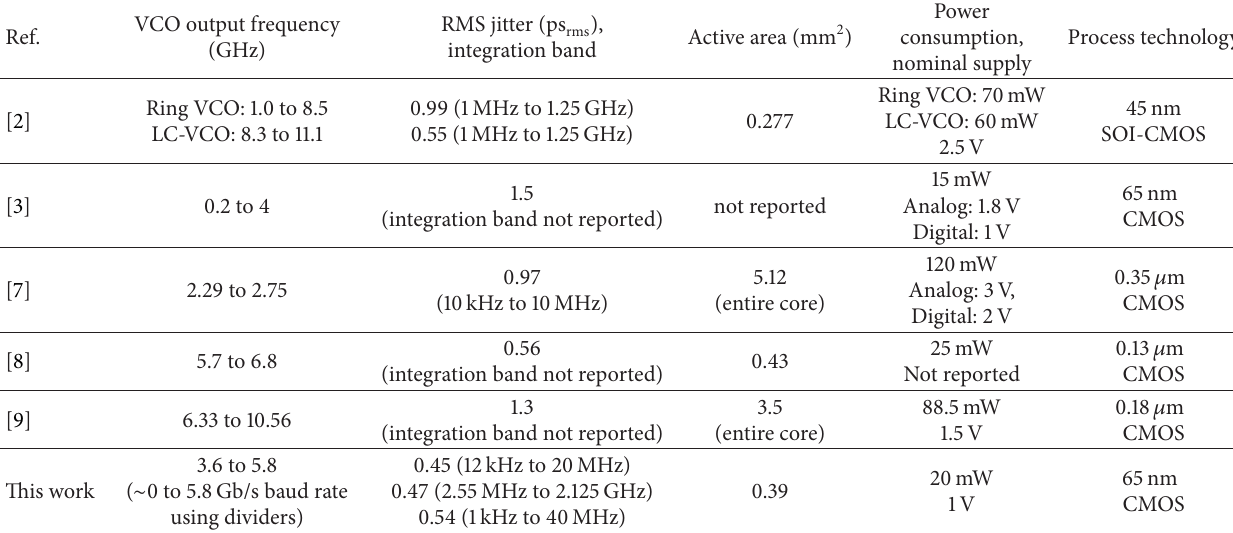
Table 3: Clock synthesizer performance summary and comparison.